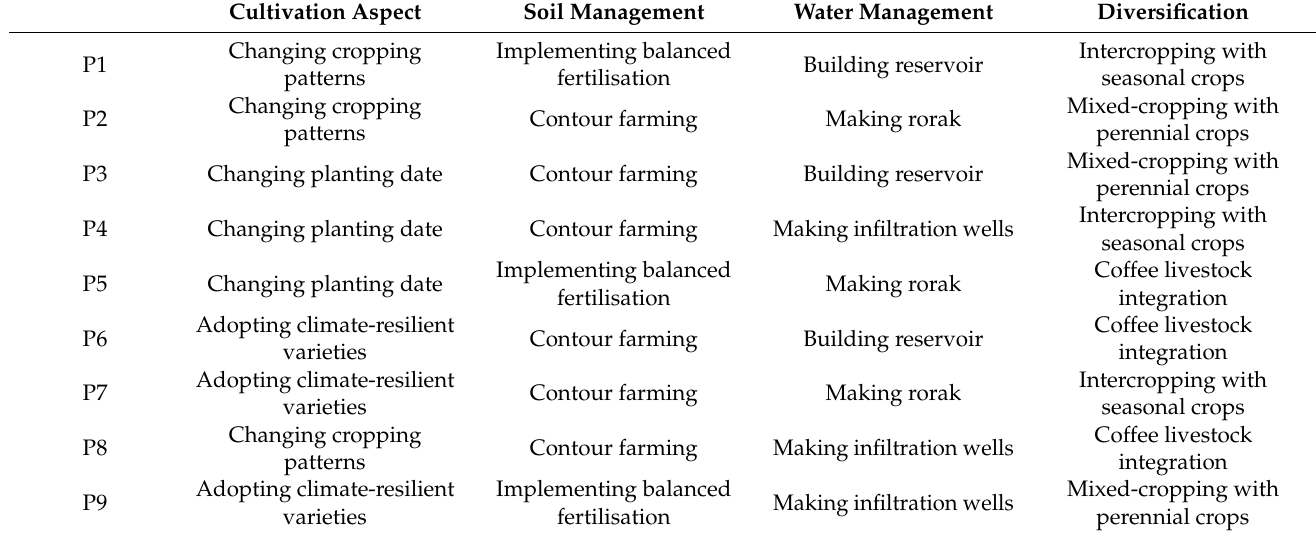
Table 4. Stimuli in